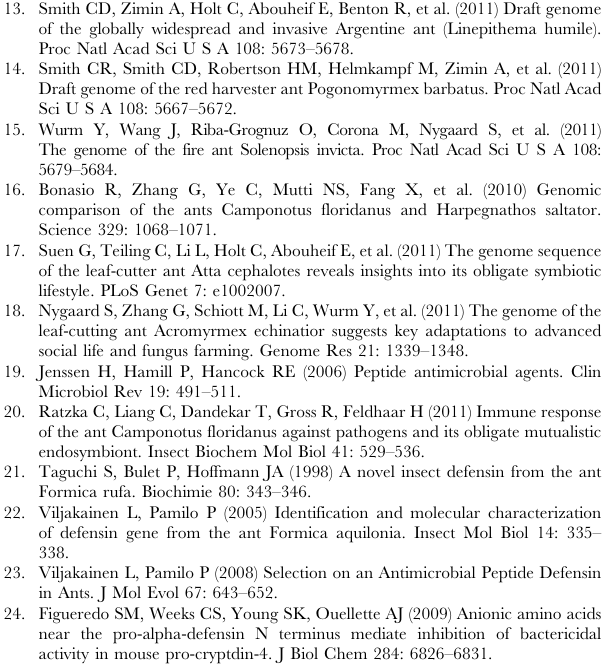
Figure S3 Ant diuretic hormone-like and ion-transport- like/CHH-like peptides. Similarity alignment of novel ant ( A ) diuretic hormone-like (DH) and ( B ) ion-transport-like peptides (ITP) with known insect peptides (UniProtKB Q9VLK4, F4X307, F4WGA3, Q1XAU6, Q1XAU8, Q9NL55, F4WAC6, Q26491 and Q1XAU8). The alignments were prepared with ClustalW2 and Boxshade. The mature peptides are presented by the box. Figure S4 Ant neuroparsin- and eclosion hormone-like peptides. Similarity alignments of novel ant ( A ) neuroparsin-like (NP) and ( B ) eclosion hormone-like (EH) peptides with known insect peptides (UniProtKB Q07892, F4WBP0 and P10776). The align- ments were prepared with ClustalW2 and Boxshade. The signal peptide cleavage site (identified by similarity) is indicated by an arrow. Figure S5 Ant tachykinin-related peptides. Similarity alignments of novel ant ( A ) tachykinin-like peptides with known insect peptides (UniProtKB Q868G6, Q9VGE8 and F4WJJ0). The alignment was prepared with ClustalW2 and Boxshade. ( B ) The mature tachykinin-related peptide (TRP) sequences from Atta